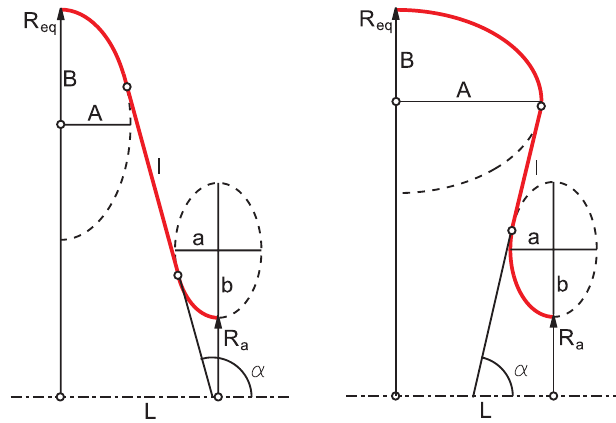
FIG. 1. (Color) Geometry of the inner cell: nonreentrant (left) and reentrant (right)